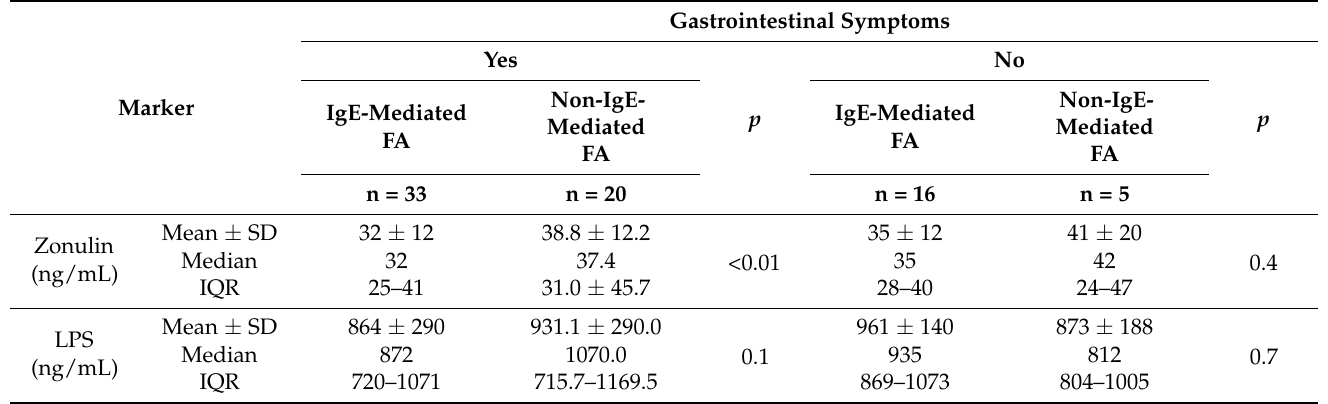
Table 4. Levels of selected IP markers vs. presence of gastrointestinal symptoms—comparison of children with IgE-mediated and non-IgE-mediated FA.